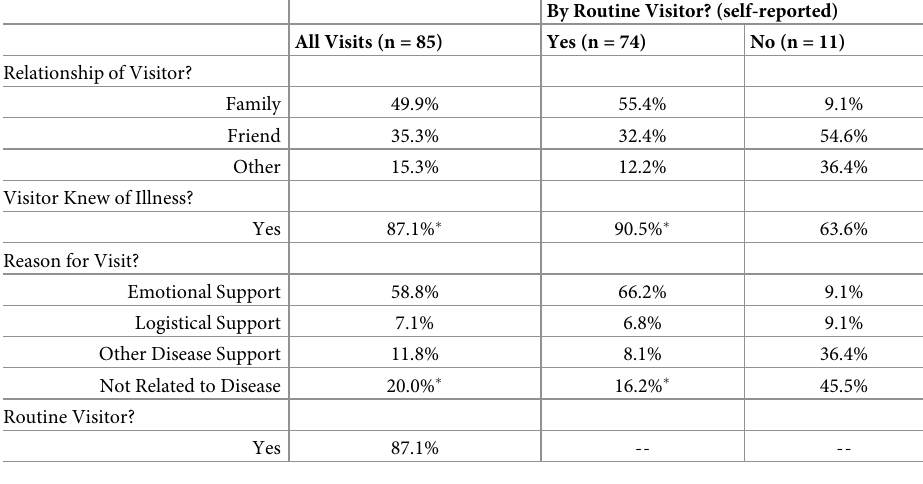
Table 2. Characteristics of visitors received during illness by symptomatic DENV infected individuals in Iquitos, Peru. Data on visits received by ill individuals and the nature of these visits. Totals and categorized by if made by rou- tine visitors. Whether the visitor knew of the illness, why they visited, and if they were classified as a ‘routine visitor’ were all reported by the ill participant. By Routine Visitor?